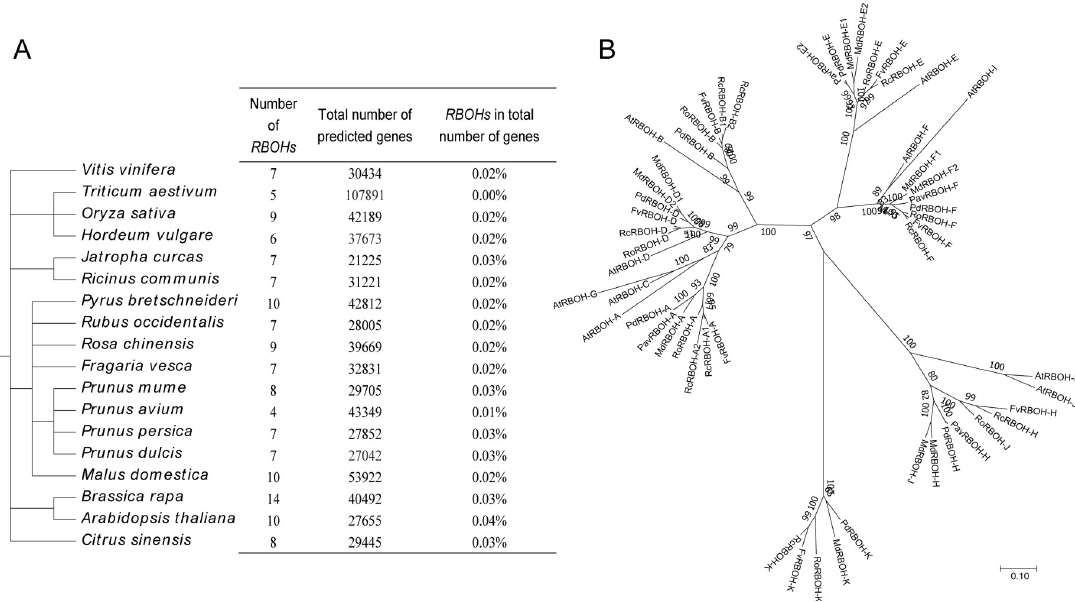
Fig 1. Phylogenetic and comparative analysis of RBOH genes from various plants. (A) A summary of the species phylogeny and the number of RBOH genes in each species. (B) Phylogenetic analysis of RBOH proteins from six Rosaceae species and Arabidopsis.